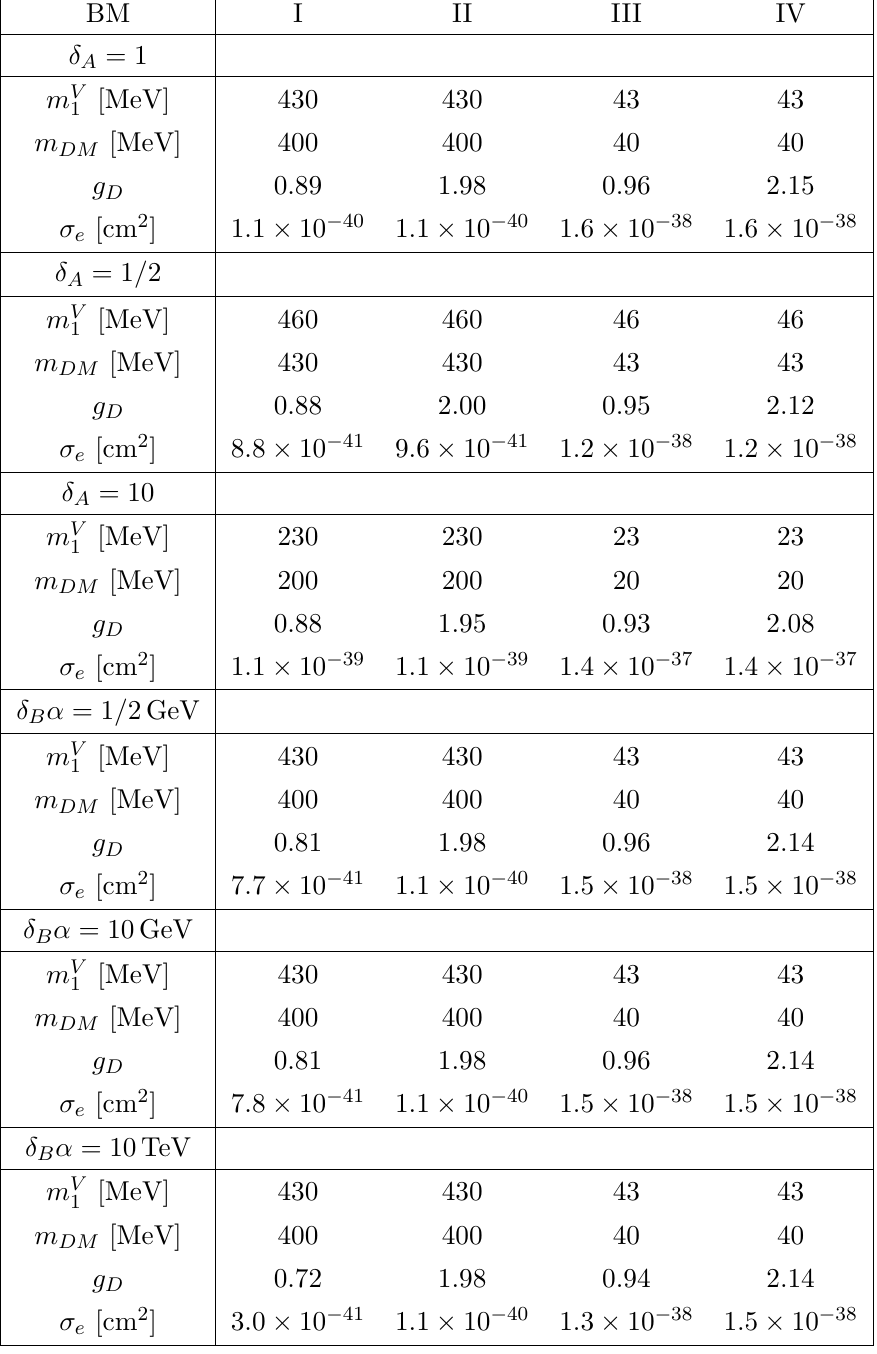
Table 2 . 4-D dark coupling g D needed to obtain the observed DM relic density, with (cid:14) A = 1 = 2 ; 1 or 10 (with (cid:14) B (cid:11) = 1 GeV), and (cid:14) B (cid:11) = 1 = 2 ; 10 GeV or 10 TeV (with (cid:14) A = 1). The maximum value for the DM mass and the lightest DP mass are also shown. For BM II and IV the DM particle is lighter than muons, thus the only channels accessible is e + e (cid:0) and neutrinos. The cross section for the scattering o(cid:11) of an electron by a DM particle is shown in the last row, using the same gauge coupling needed to satisfy the DM relic abundance.